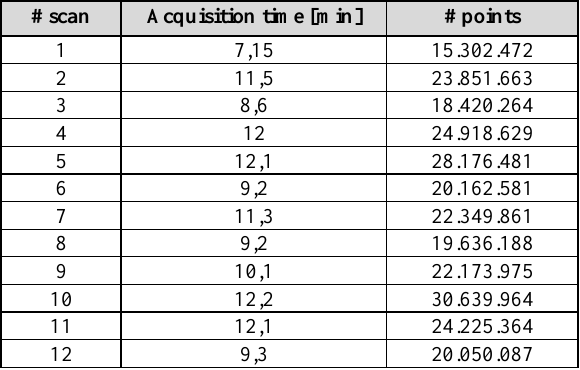
Table 4. MMS datasets